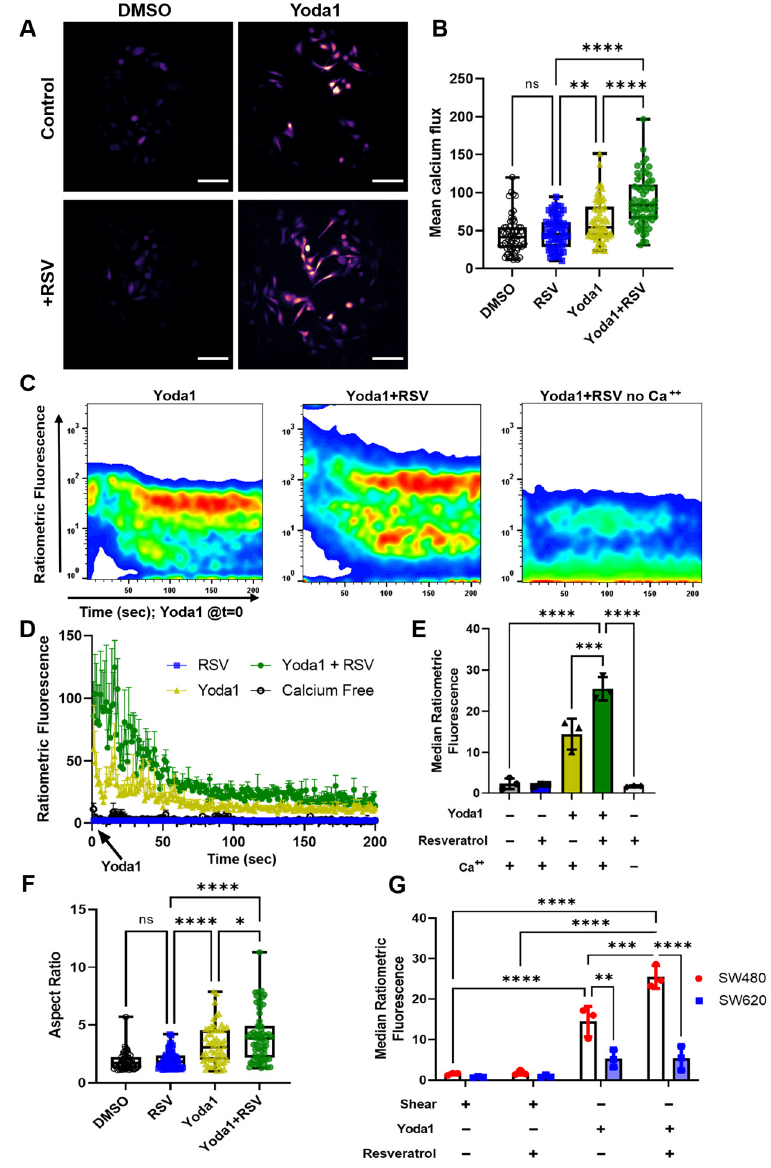
Figure 6. Resveratrol increases calcium influx from Yoda1 in the more mechanosensitive SW480 cells. ( A ) Calcium imaging of Fluor-4 fluorescence after 24 h treatment of 10 µ M Yoda1.